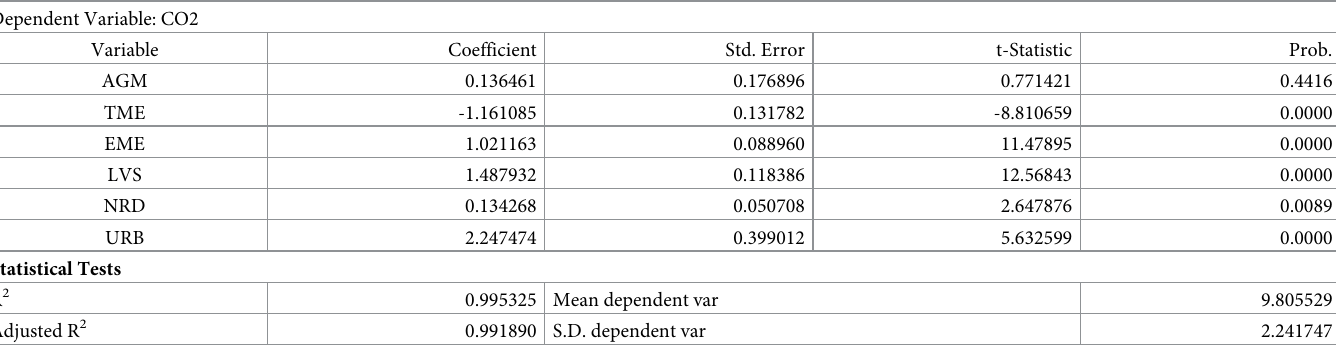
Table 9. Panel dynamic OLS estimates.